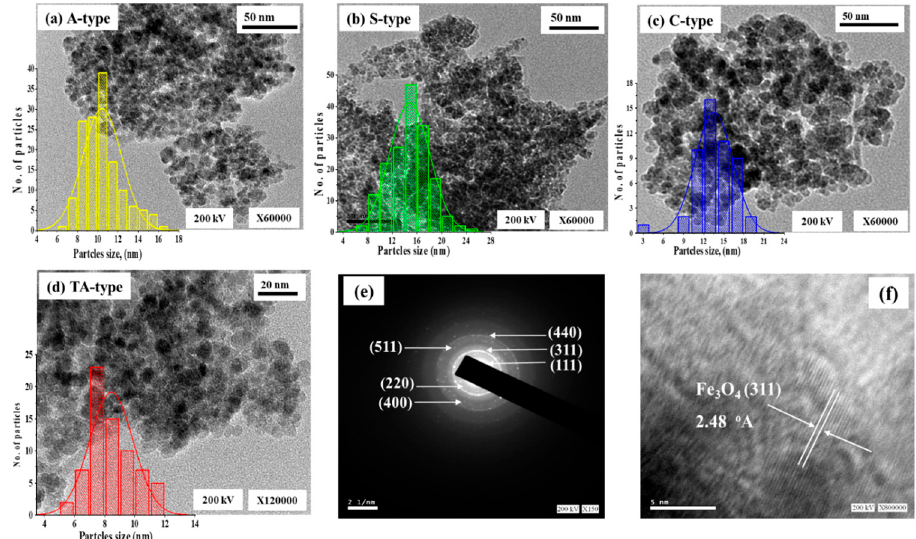
Figure 1. Particle sizes distribution using TEM micrographs and histograms for A-type, S-type, and C-type ( a – c ), and for TA-type ( d ), SAED analysis ( e ), and crystal lattice HRTEM picture ( f ).